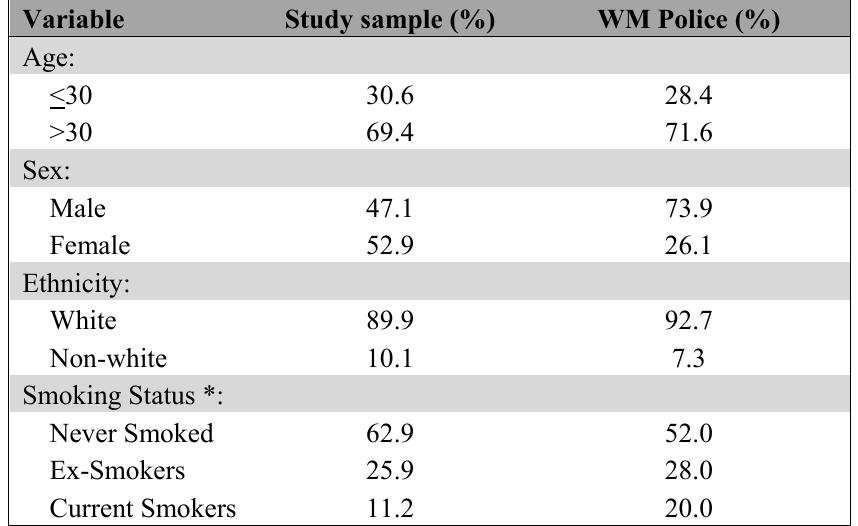
Table A1. Comparison of Baseline Characteristics between study sample and total WM police